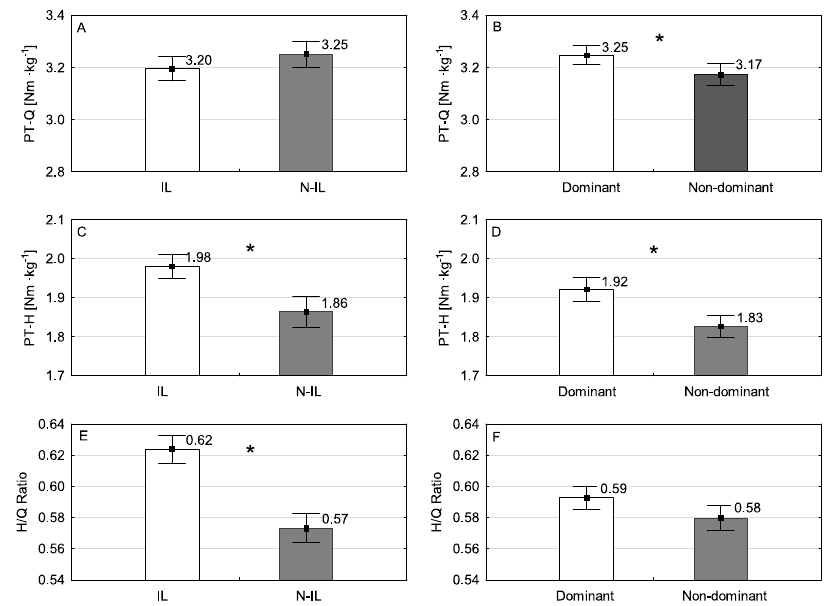
Figure 1. Mean values and standard error for PT of quadriceps and hamstrings by: ( A , C ) soccer player groups (international, non-international); ( B , D ) legs (dominant, non-dominant), and H/Q ratios by: ( E ) soccer player groups (international, non-international); ( F ) legs (dominant, non-dominant).